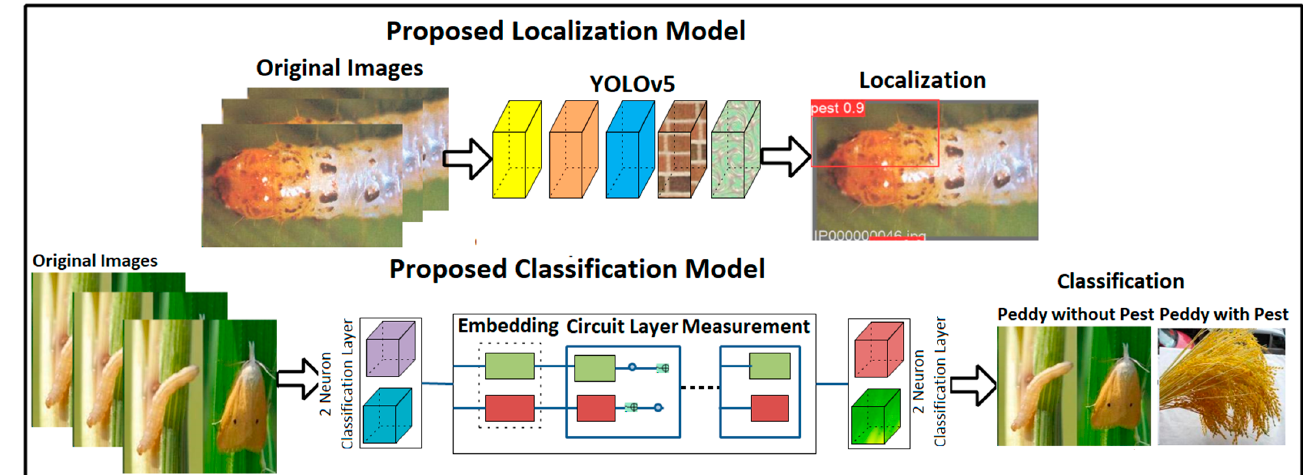
Figure 1. Proposed pest localization and classification models.